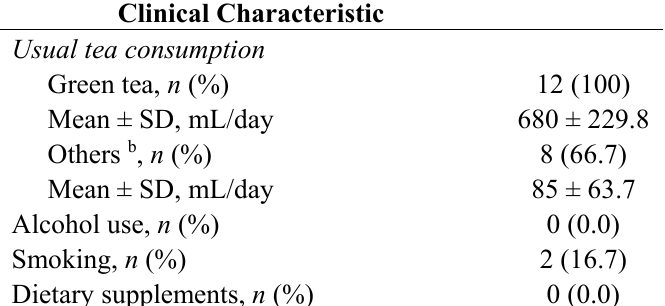
Clinical Characteristic